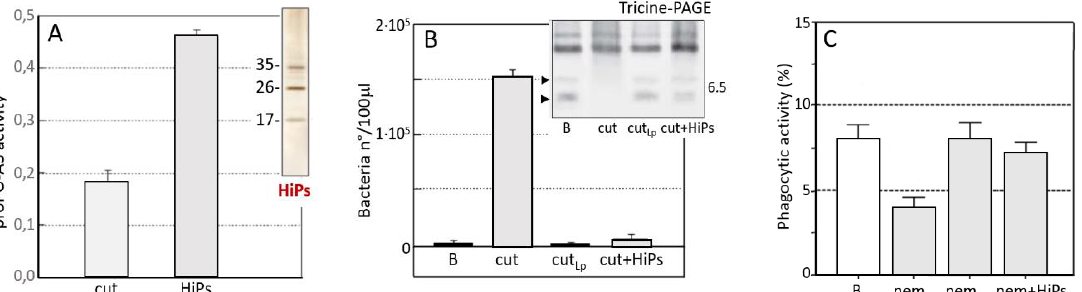
Figure 15. Effects of S. feltiae and its cuticles on the host immune processes. ( A ): The activity of host proPO-AS, inhibited by the presence of S. feltiae cuticles, was restored by the addition of host-interacting proteins (HiPs) eluted from the parasite surface after co-incubation with host hemolymph. Inset: an SDS-PAGE of HiPs. ( B ): The presence of cuticles interferes with AMPs synthesis, since a marked growth of bacteria in the hemolymph from cuticle-injected larvae is observable (cut). Treatments with lipase (cut Lp ) or addition of HiPs (cut + HiPs), result in a marked bacterial clearance. Inset: presence/absence of AMPs bands after Tricine-PAGE analysis of hemolymph. ( C ): effects of S. feltiae on phagocytic activity of G. mellonella in the presence of: untreated nematodes (nem), lipase-treated nematodes (nemLp), nematodes plus purified HiPs (nem + HiPs). The presence of nematodes significantly reduces the phagocytosis, lipase treatments or HiPs addition, restore the phagocytosis activity, (from